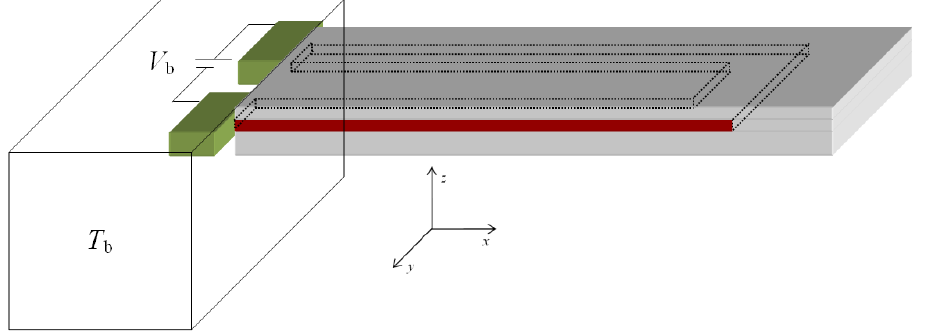
Figure 1. Schematic design of a piezoresistive microcantilever with U-shaped